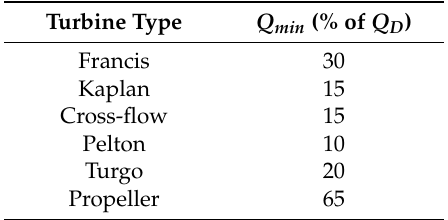
Table 6. Minimum operating flow of turbines; Penche